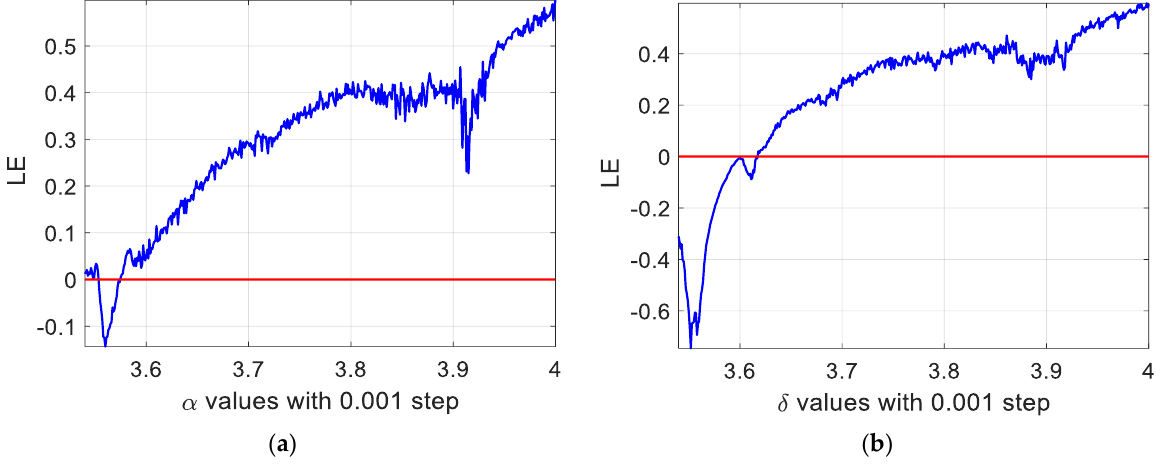
Figure 2. LE of x ( a ) and y ( b ) sequences produced by 2DSCLM for , [3.54...4]  , 0.02  = = , 0 . 5 xy == . and and x 0 = y 0 = 00